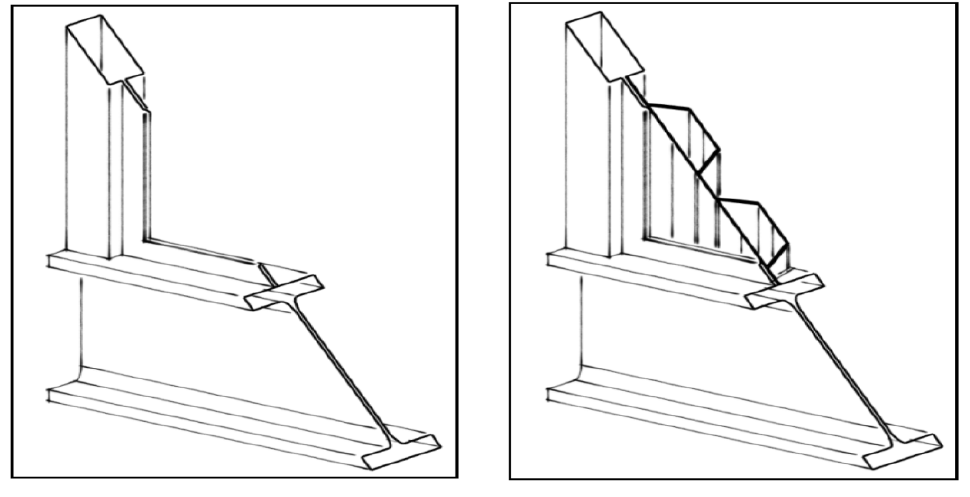
Figure 3. Frames without shear panels and frames with shear panels,